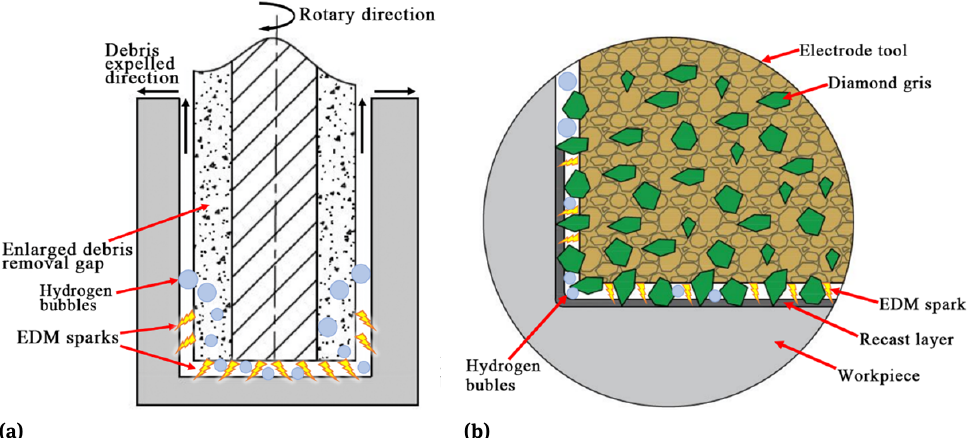
Figure 3: Schematic diagram of synchronous hybrid ECDGM: (a) debris discharge using shaped abrasive electrode; (b) partial enlargement diagram of the